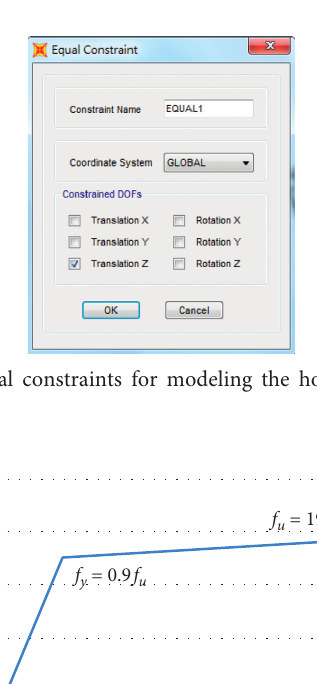
Figure 7: Whole structure with steel and RC substructures. (a) Bird view, (b) side view-1, and (c) side view-2.